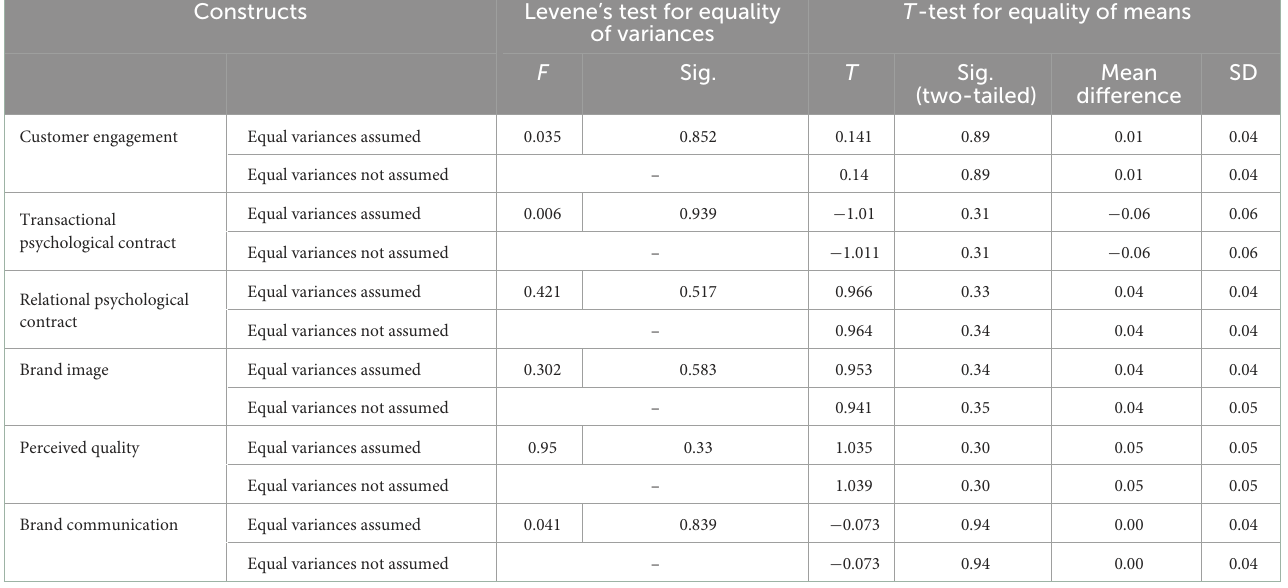
TABLE 3 Independent-sample t -test for variation in the methods for instruments.